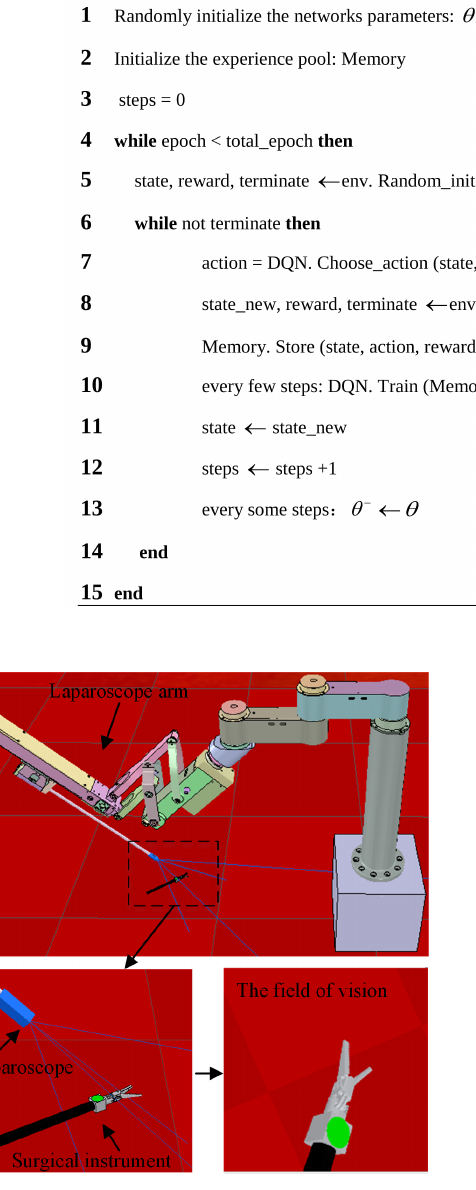
Figure 7. V-REP scene.